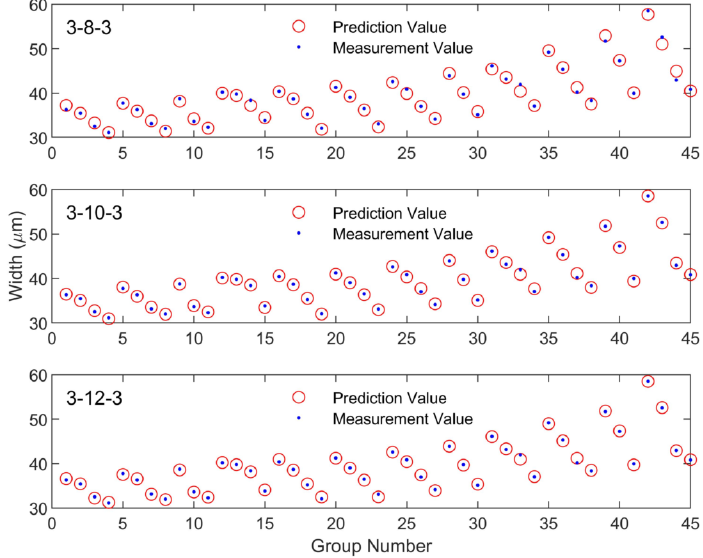
Figure 12. Comparison between the measurement and prediction values of W obtained by three types of network models.